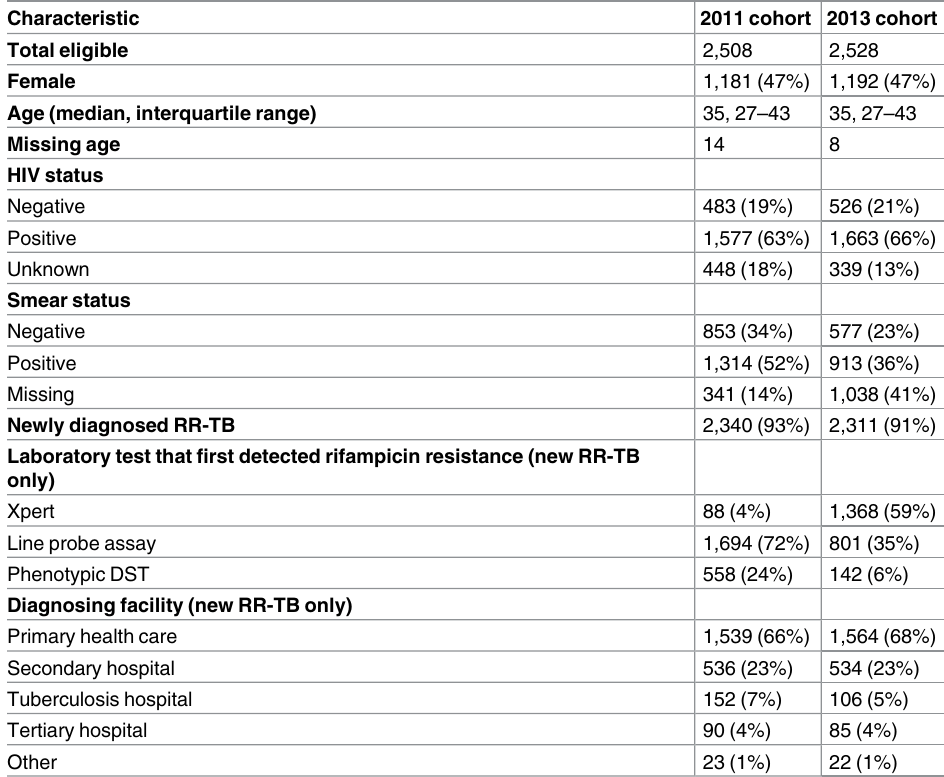
Table 1. Demographic and clinical data by